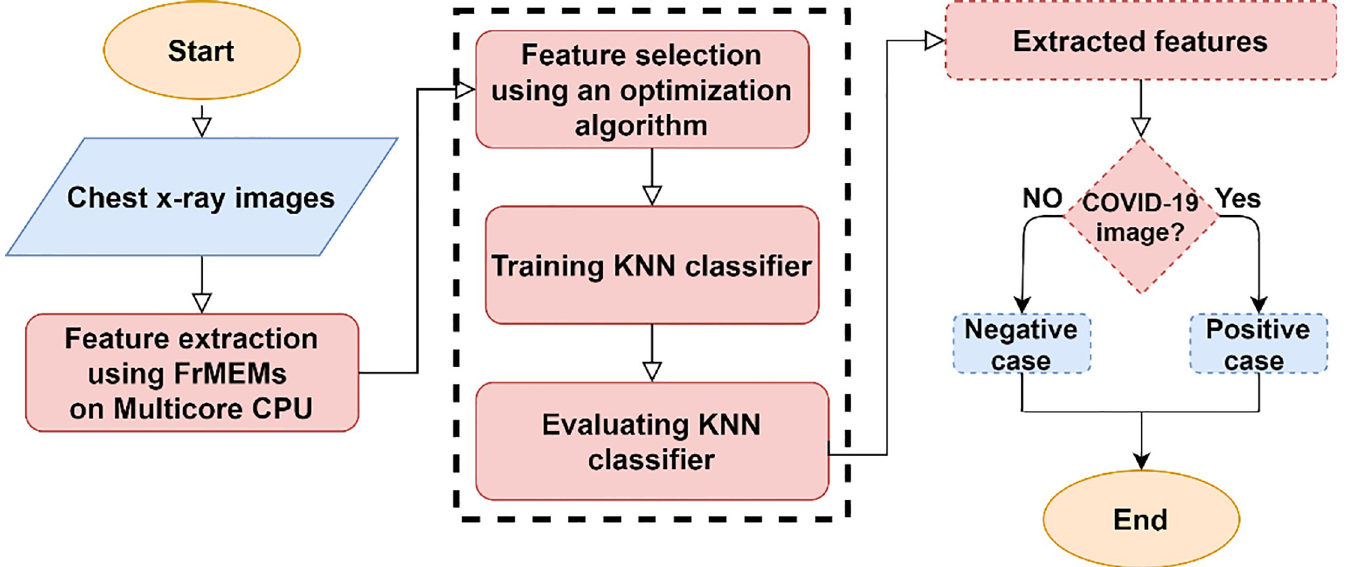
Fig 2. Flowchart of the proposed